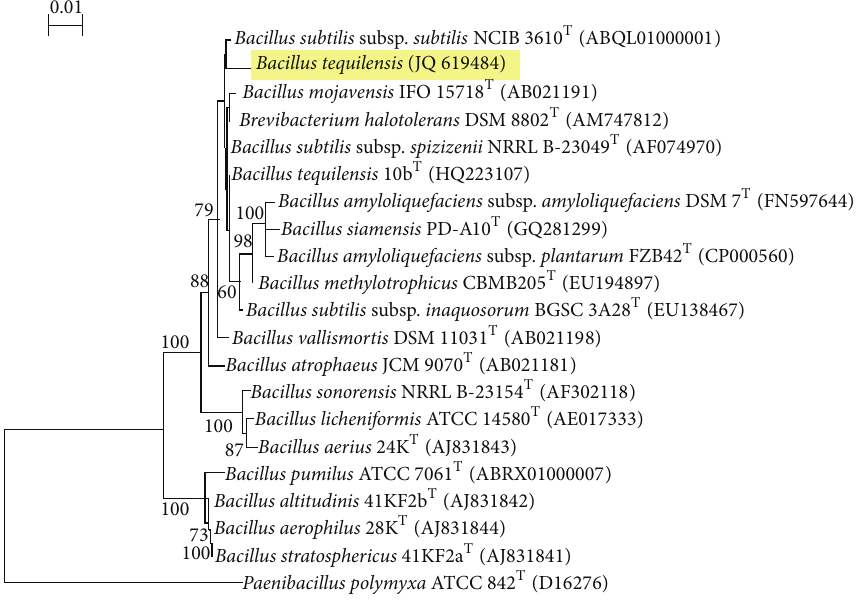
Figure 1: Phylogenetic tree showing relation between strain RG-01 and other Bacillus